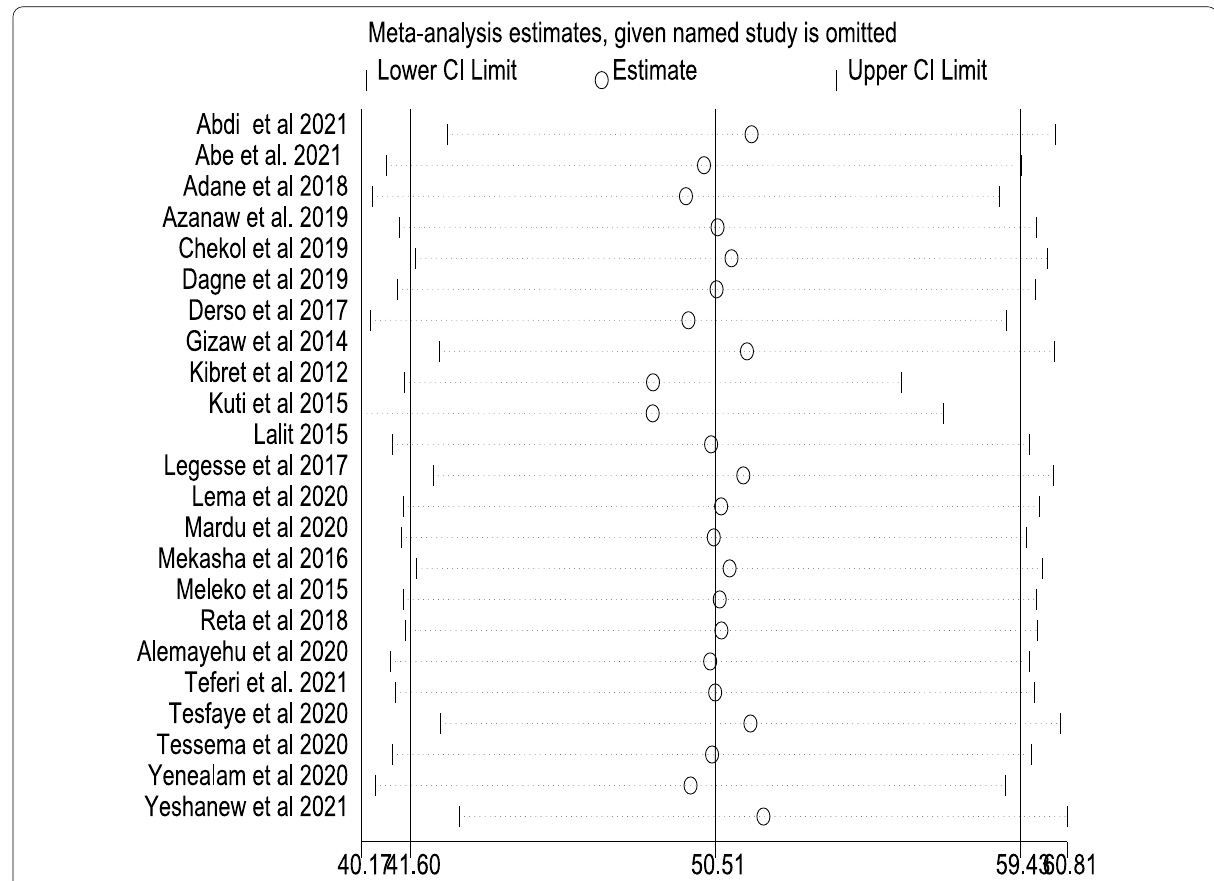
Fig. 3 Sensitivity analysis of the level of food hygiene practice removed at a time: Prevalence and 95% confidence interval of good food hygiene practice among food handlers in Ethiopia